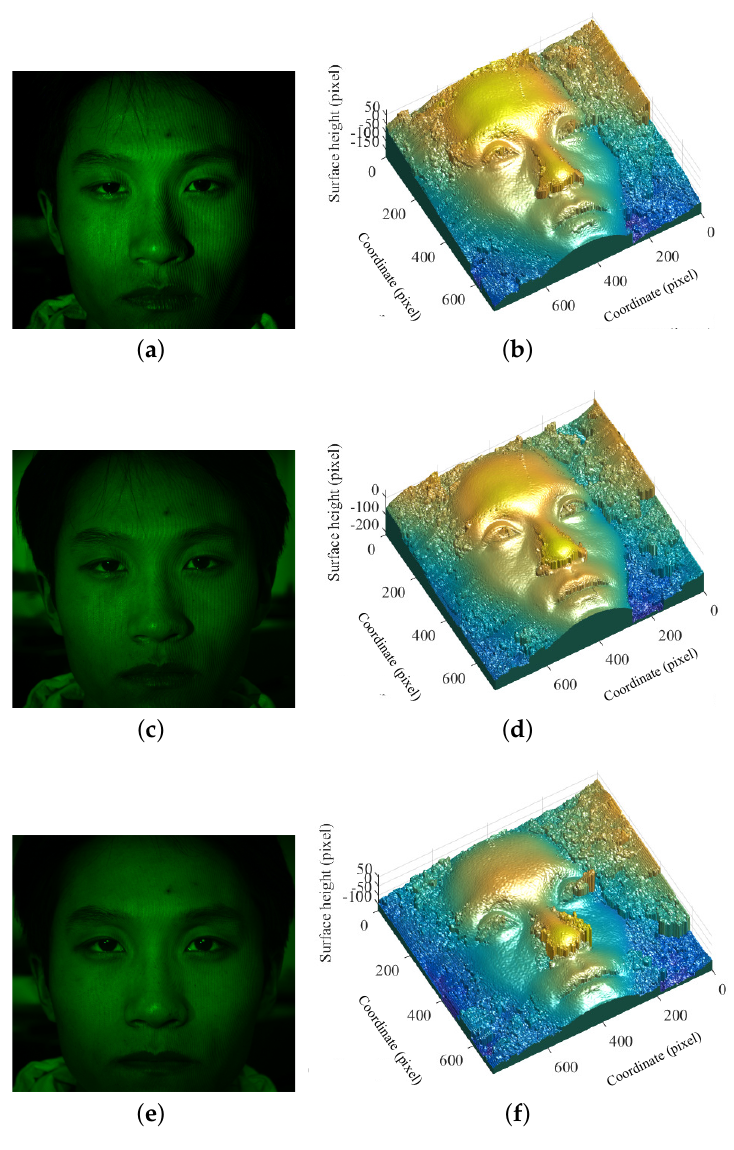
Figure 8. Measurement and reconstruction of a static human face at spatial frequency of 1.0 lp /mm and different background illuminance E : ( a ) measurement at E = 0; ( b ) reconstruction using (a); ( c ) measurement at E = 50 Lux ; ( d ) reconstruction using (c); ( e ) measurement at E = 175 Lux ; and ( f ) reconstruction using